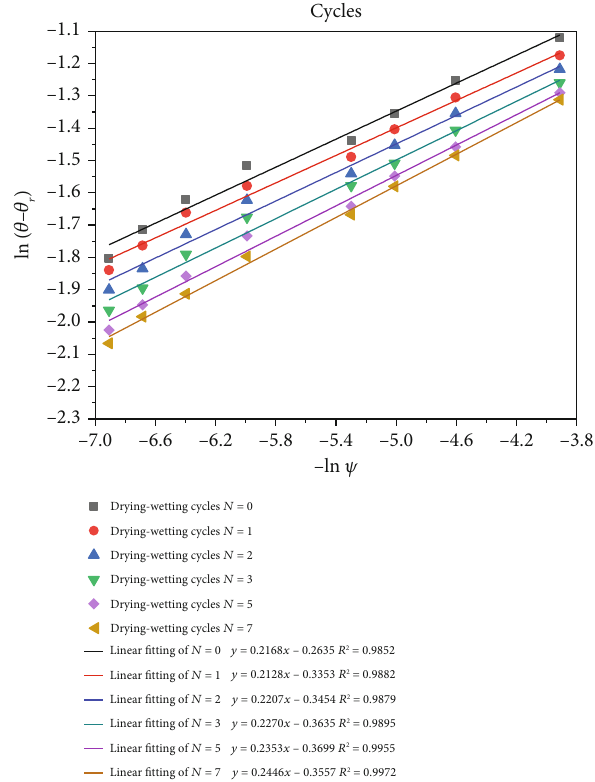
Þ against – ln ψ for residual r